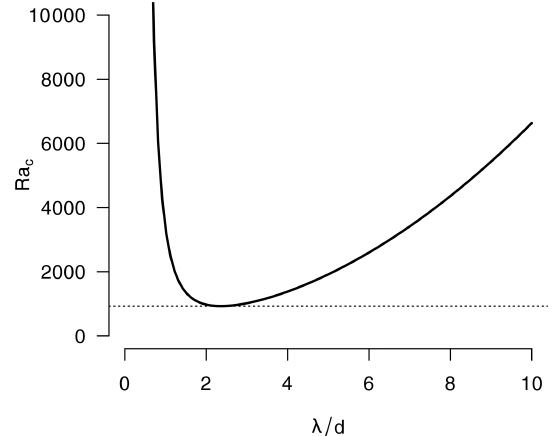
Figure 1. Marginal stability curve of Rayleigh–Bénard convection for classic rigid–rigid boundary conditions. For any given wave- length λ (relative to the fluid depth d ), eddies grow if the Rayleigh number lies above the curve and decay